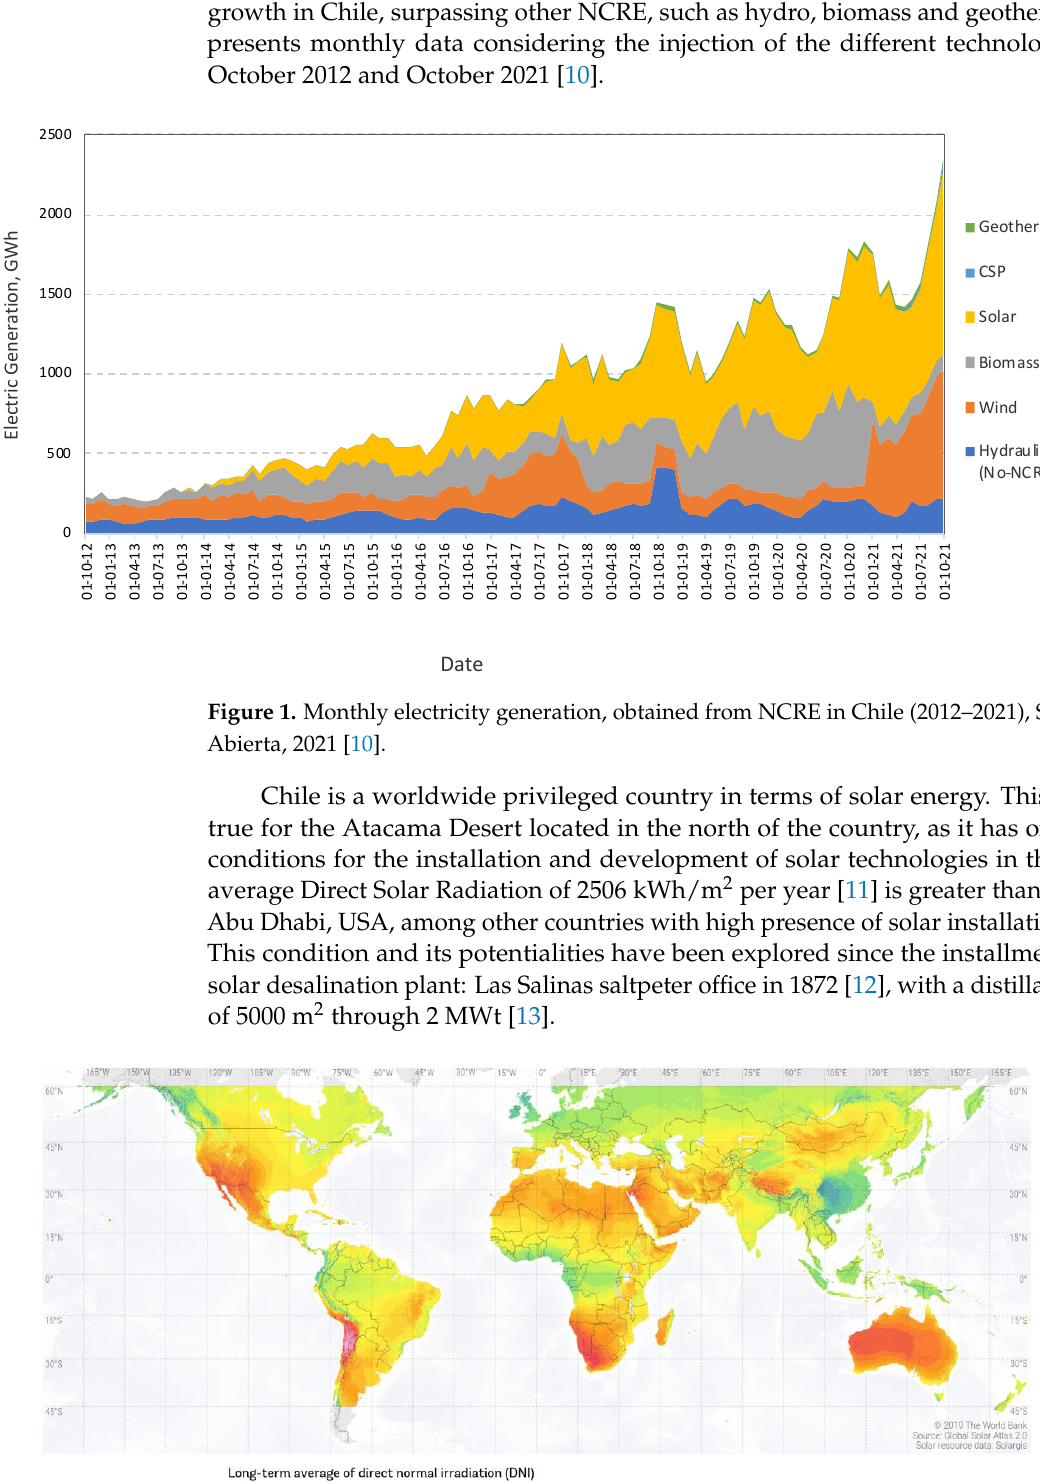
Table 1. Status of NCRE projects in Chile [15]. Technology